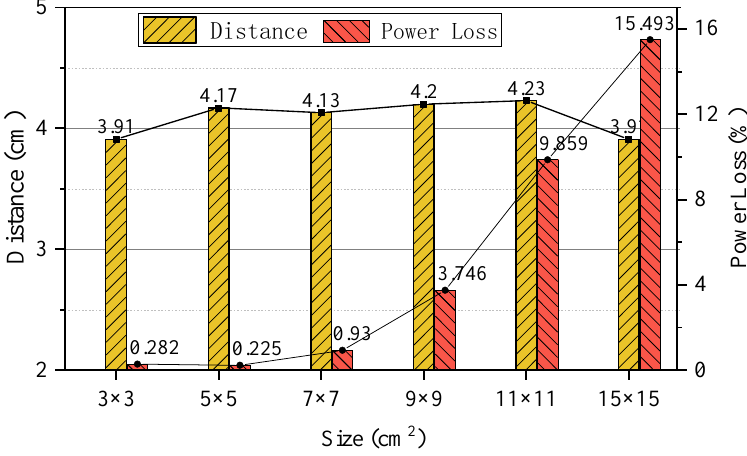
Figure 12. Distance and power loss of different size iron absorbed by the receiving coil.